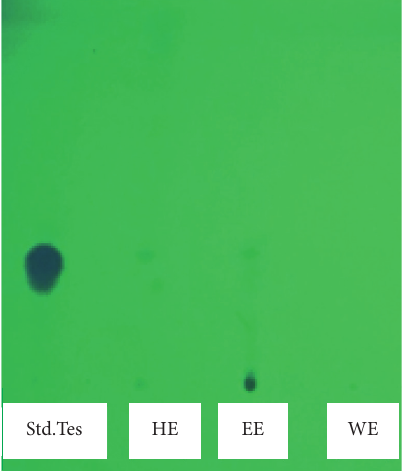
Std.Tes Figure 2: TLC patterns of testosterone standard (Std. Tes), hexane extract (HE), 75% v / v ethanol extract (EE), and water extract (WE) observed under UV light at 254 nm using hexane: ethyl acetate: acetic acid (60: 40: 0.5, v / v / v ) as a mobile phase.